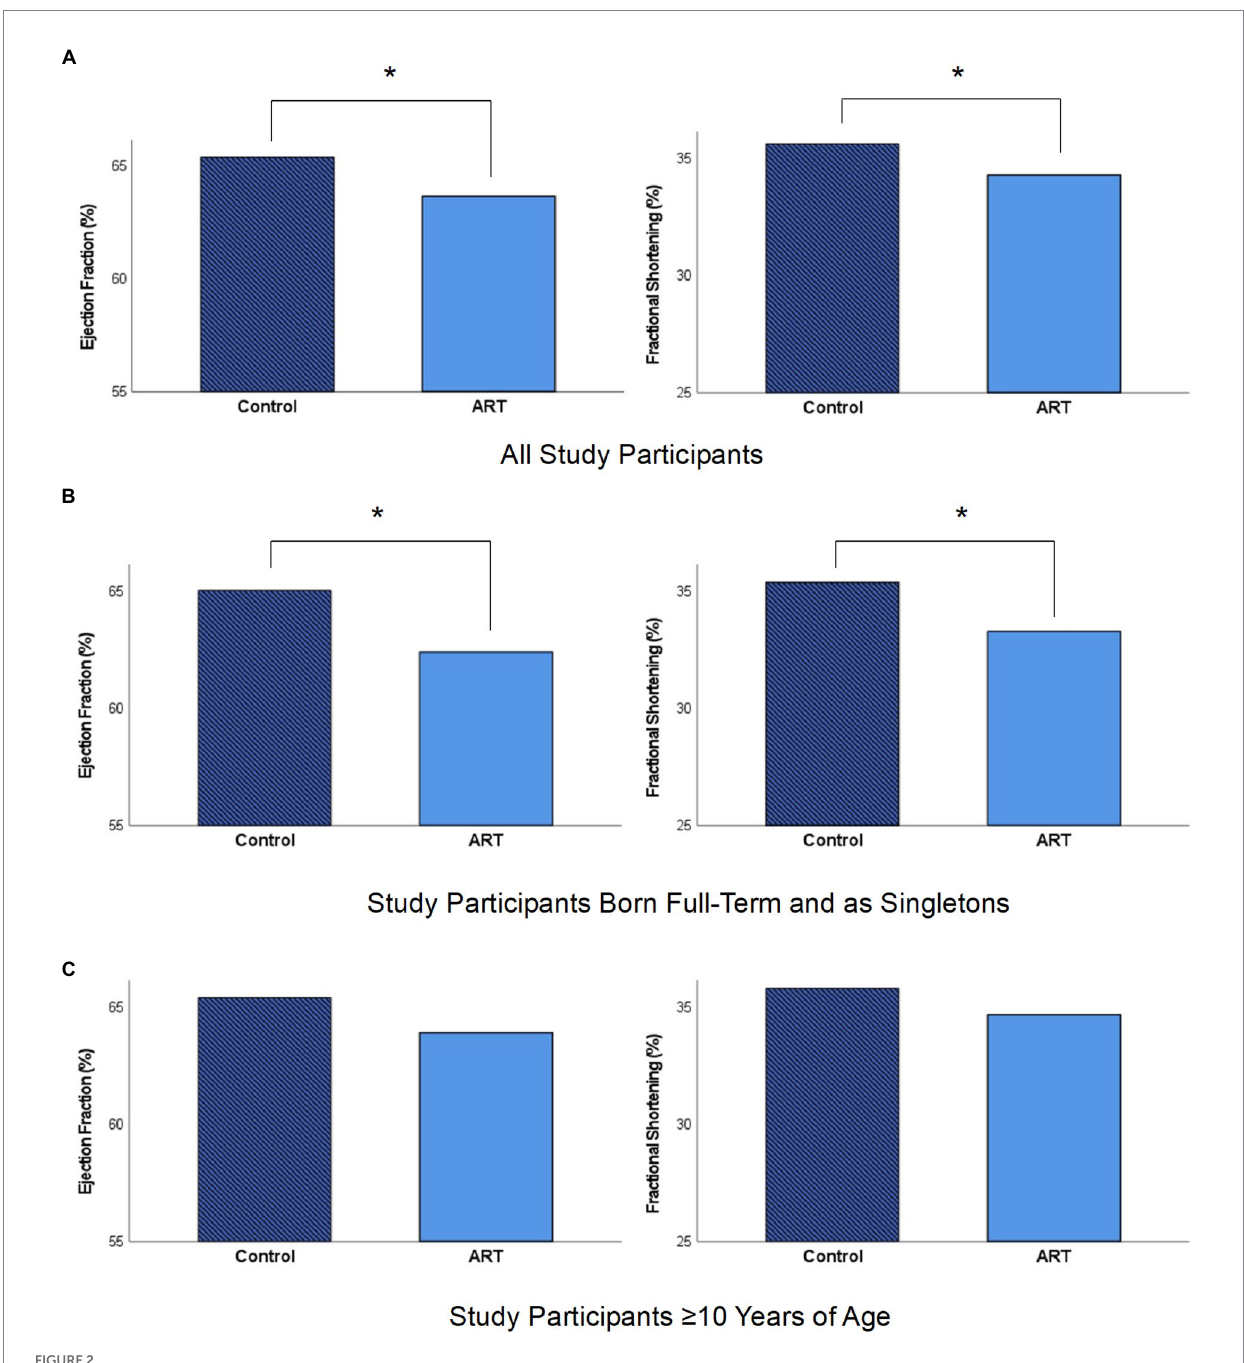
FIGURE 2 Left ventricular ejection fraction and fractional shortening assessed by M -mode echocardiography in the control and ART group. (A) Eighty-three control subjects and 64 ART subjects displayed significant differences for ejection fraction (65.35 ± 5.10 % vs. 63.63 ± 5.17 %, p = 0.046, adjusted p = 0.576) and fractional shortening (35.60 ± 3.84 % vs. 34.26 ± 3.87 %, p = 0.038, adjusted p = 0.543). (B) Fifty-nine control subjects and 20 ART subjects that were born on full term ( ≥ 37 weeks of gestation, birth height ≥ 10. P., birth weight ≥ 10. P.) and as singletons displayed significant differences for ejection fraction (65.01 ± 5.00 % vs. 62.38 ± 4.99 %, p = 0.046, adjusted p = 0.280) and fractional shortening (35.35 ± 3.77 % vs. 33.26 ± 3.67 %, p = 0.034, adjusted p = 0.224). (C) Fifty-two control subjects and 36 ART subjects ≥ 10 years of age displayed no significant differences for ejection fraction (65.37 ± 4.97 % vs. 63.88 ± 5.25 %, p = 0.182, adjusted p = 0.576) and fractional shortening (35.77 ± 3.74 % vs. 34.65 ± 3.97 %, p = 0.183, adjusted p = 0.570). All parameters were obtained from M -mode echocardiography in parasternal long axis view. * Value of p <